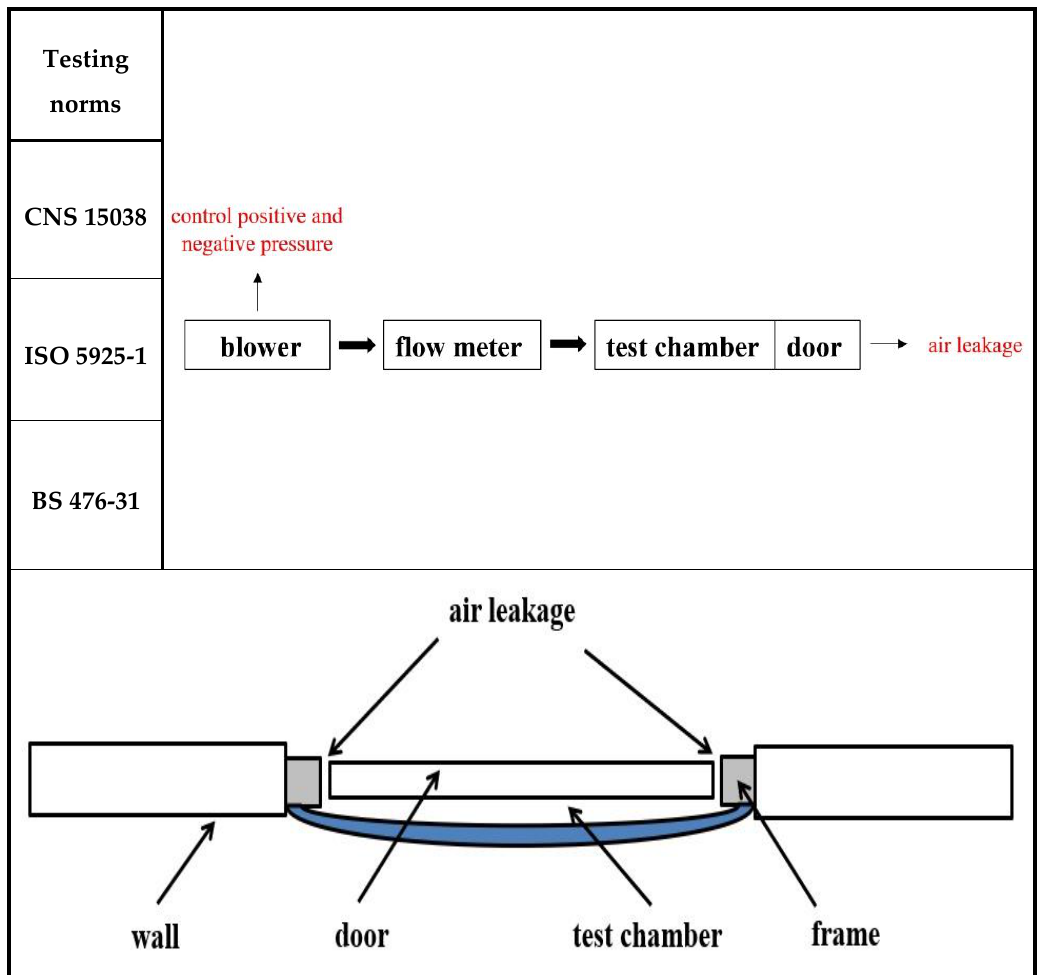
Figure 1. Configuration of the test equipment.